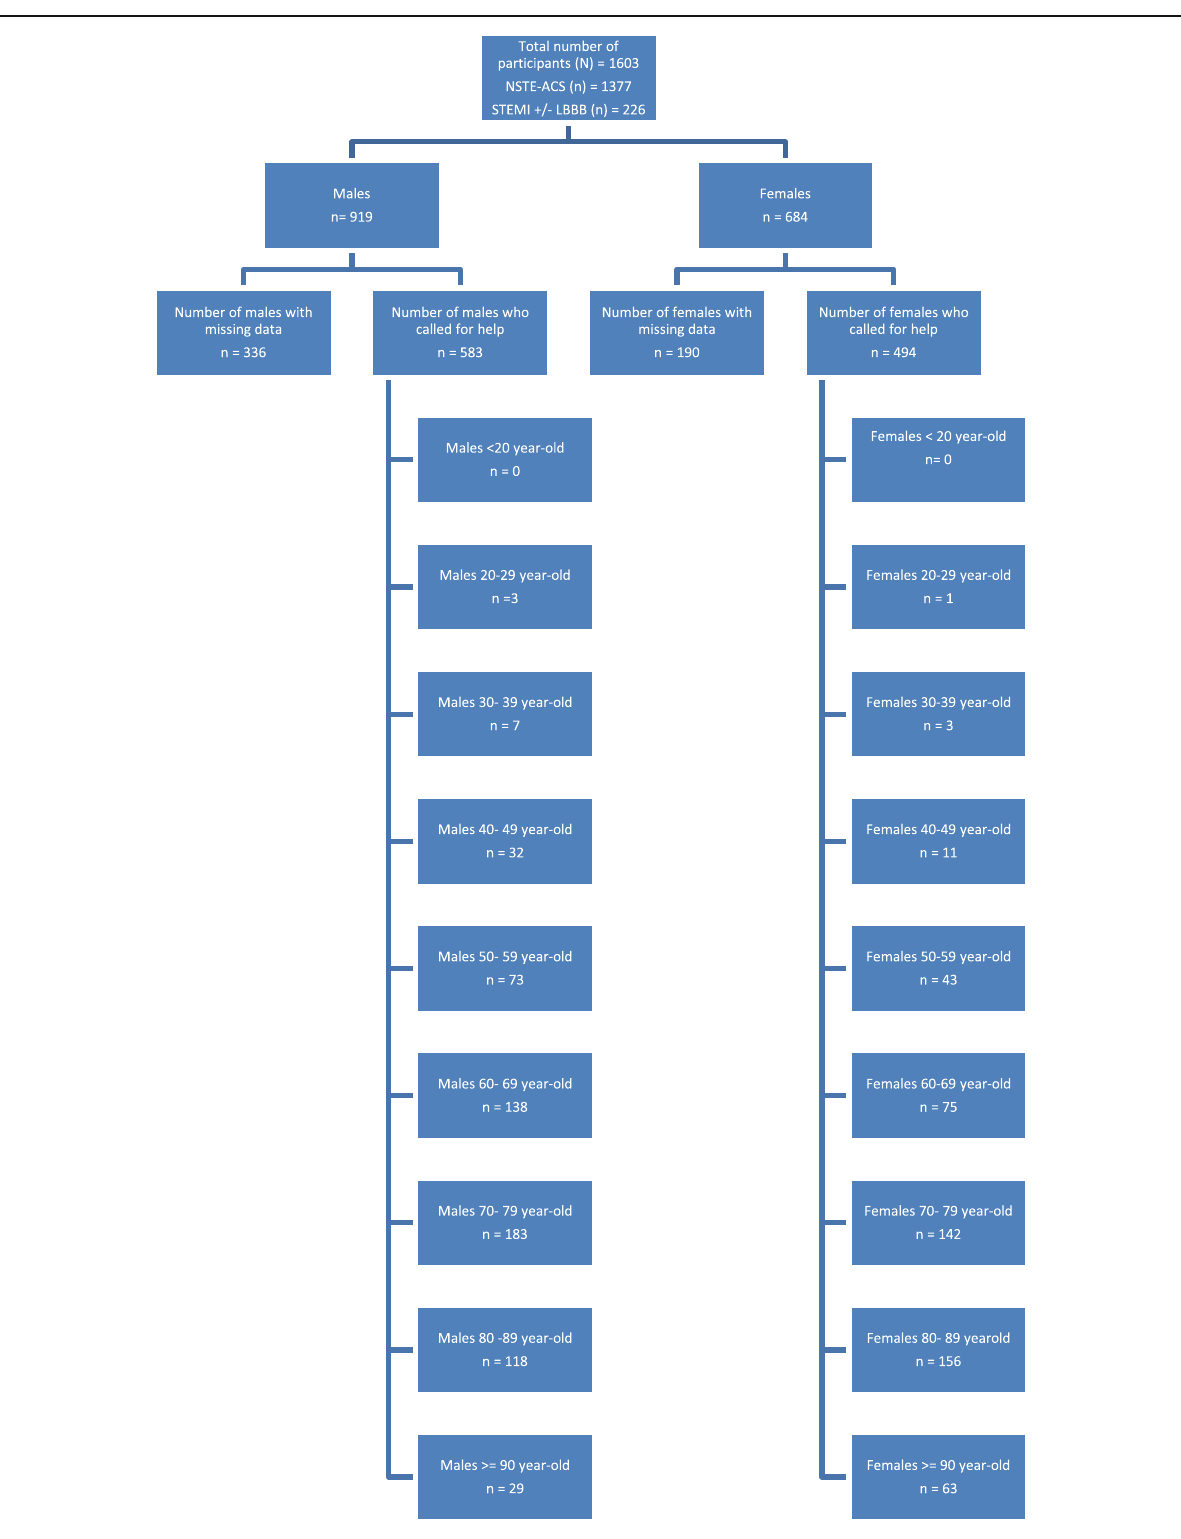
Fig. 1 A flow chart demonstrates the number of participants from both gender and different age groups who called for help. It shows the number of participants with missing data for their time from symptoms onset to call for